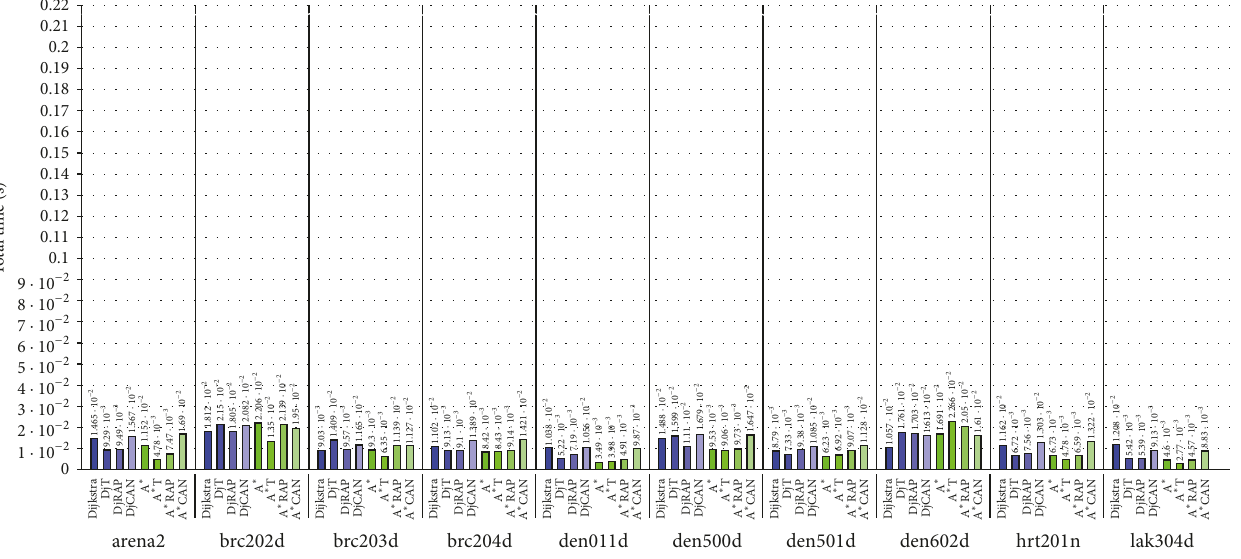
Figure 13: Time performance for 10 maps of Dragon Age: Origins .